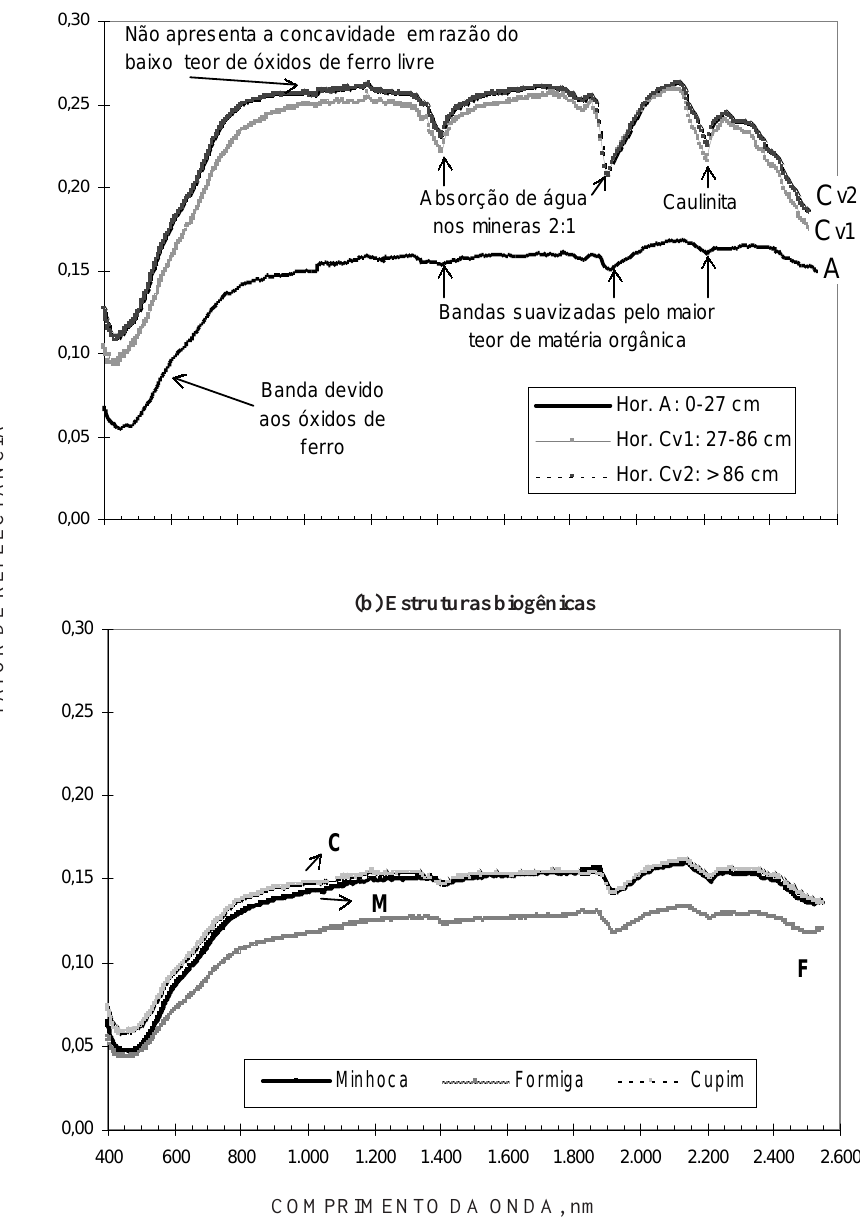
COMPRIMENTO DA ONDA, Figura 6. Comportamento espectral dos horizontes do Vertissolo (a) e das estruturas biogênicas (b).